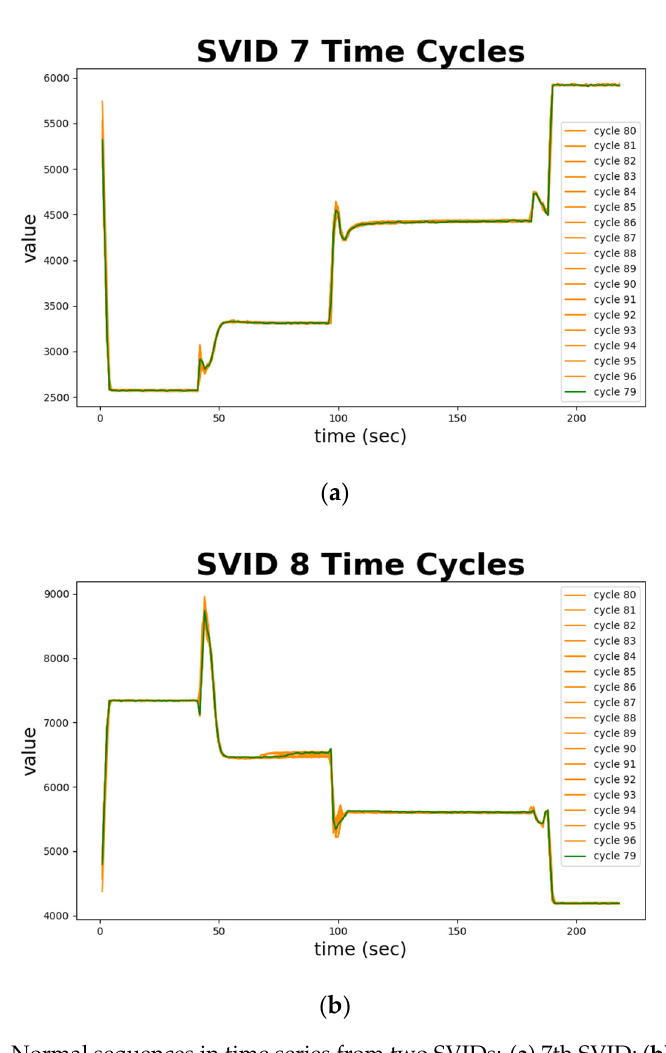
Figure 12. Normal sequences in time series from two SVIDs: ( a ) 7th SVID; ( b ) 8th SVID.